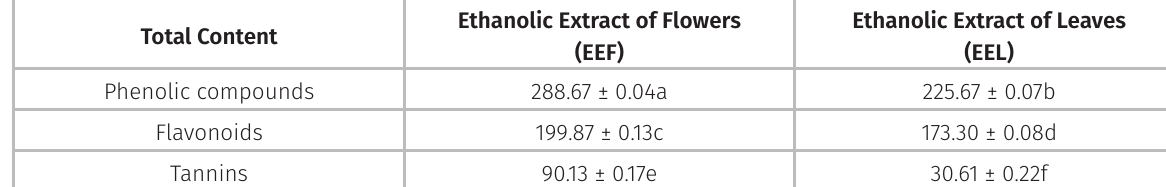
Table I. Total phenolic content (expressed in mean ± SD mg 3,4,5-trihydroxybenzoic acid equivalent/g dry weight), flavonoids content (expressed in mean ± SD mg 3,3’,4’,5,7-pentahydroxyflavone equivalent/g dry weight), and tannins content (expressed in mean ± SD mg 2-(3,4-dihydroxyphenyl)-3,4-dihydro-2H-1-benzopyran-3,5,7-triol equivalent/g dry weight) in Banisteriopsis laevifolia extracts.